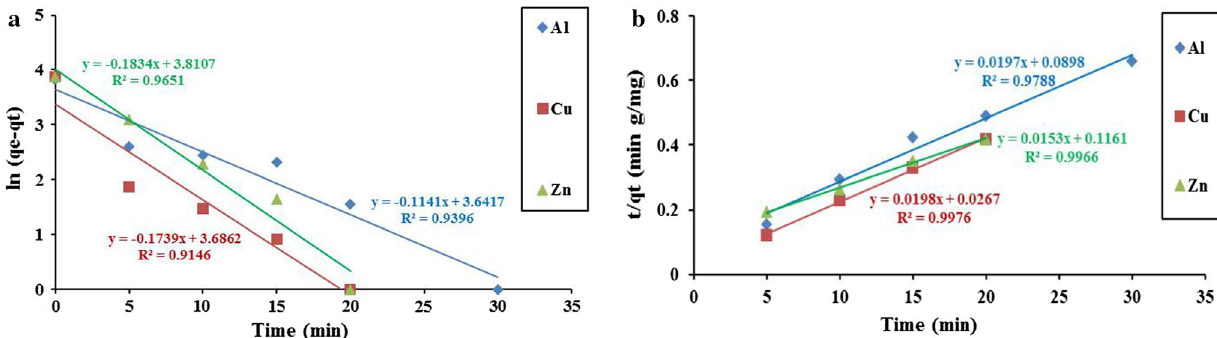
Fig. 10 a Pseudo-first-order plot of Al(III), Cu(II) and Zn(II) adsorption by MZNCs at pH = 5 for (Al), pH = 6 for (Cu and Zn) and 27 °C. b Pseudo-second-order plot of Al(III), Cu(II) and Zn(II) adsorption by MZNCs at pH = 5 for (Al), pH = 6 for (Cu and Zn) and 27 °C